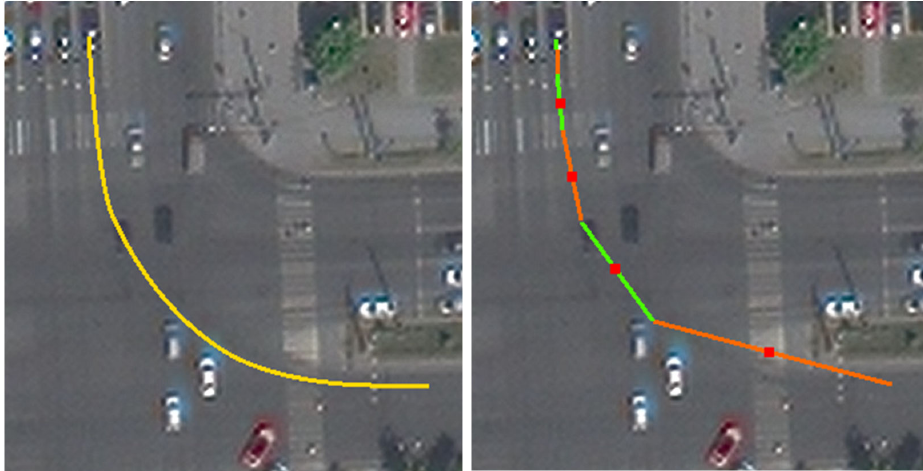
Figure 3. The path of a mobile emissions source and the same path broken into 5-s segments.